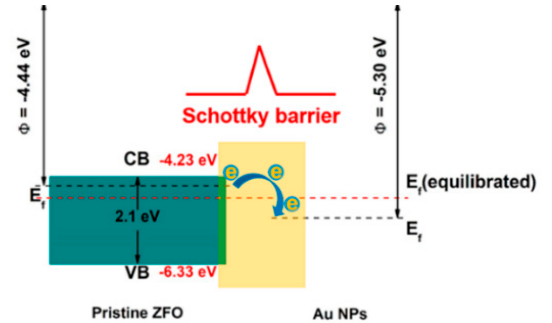
Figure 21. Sensing mechanism of the Au-ZnFe 2 O 4 core-shell-sphere-based sensor in energy band diagram [90].